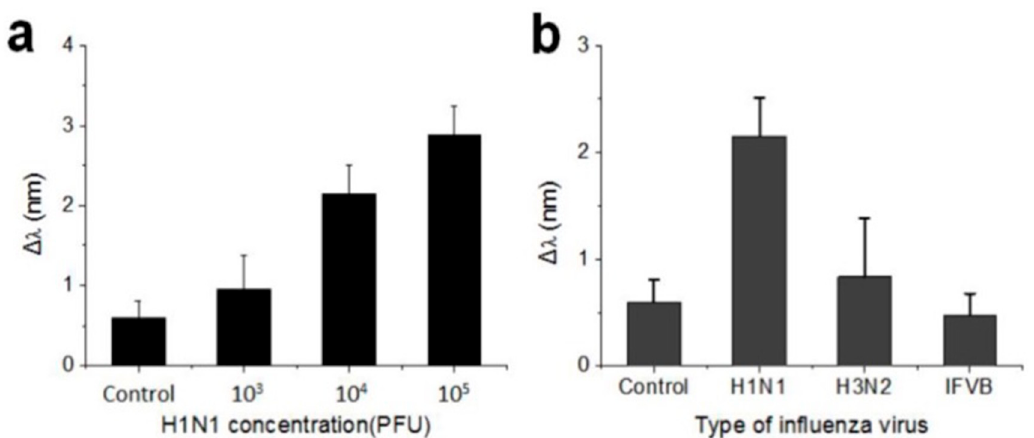
Figure 10. ( a ) Shift of reflectance peak as a function of H 1 N 1 virus subtype concentration, for concentrations ranging from 10 3 to 10 5 PFU in 10 L. Phosphate-buffered saline (PBS) solution is used for the control; ( b ) Shift of the reflectance peak depending on the type of virus, for a concentration equal to 10 4 PFU for all influenza viruses, namely A (H 1 N 1 ), A (H 3 N 2 ), and B (IFVB). Specificity to the H 1 N 1 is evident. Reproduced from [83] under CC BY 4.0 License.